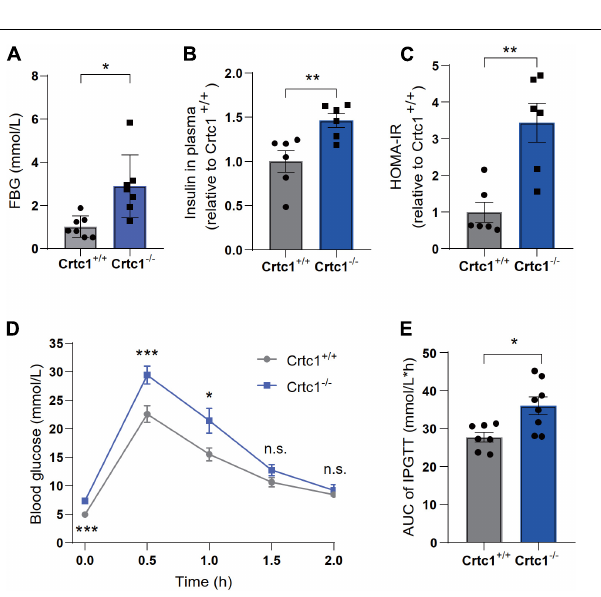
FIGURE 4 | Crtc1 deficiency damages glucose tolerance in mice. (A) Fasting blood glucose (FBG). (B) Fasting plasma insulin, (C) and HOMA-IR. (D) The curve of blood glucose level with time. (E) Area under the plasma glucose concentration curve (AUC) in Crtc1 + / + and Crtc1 − / − mice at the age of 8 months. Data are mean ± SEM; * P < 0.05; ** P < 0.01, *** P < 0.001 and n.s. indicates no significant